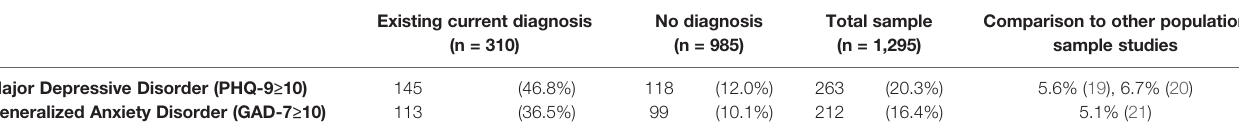
Comparisons samples are general population samples from the USA (19) and Germany (20, 21). To the best of our knowledge, there are no published pre-pandemic norms from the Australian national population for these